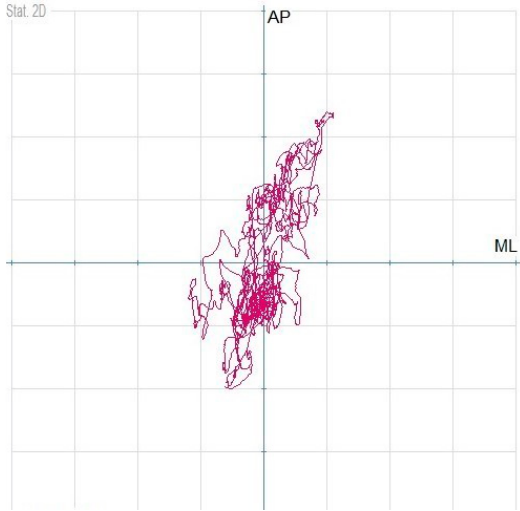
Appl. Sci. 2022 , 12 , 12454 Figure 1. Diagram showing path length sample for COP during EO L test. Figure 1. Diagram showing path length sample for COP during EO L test.